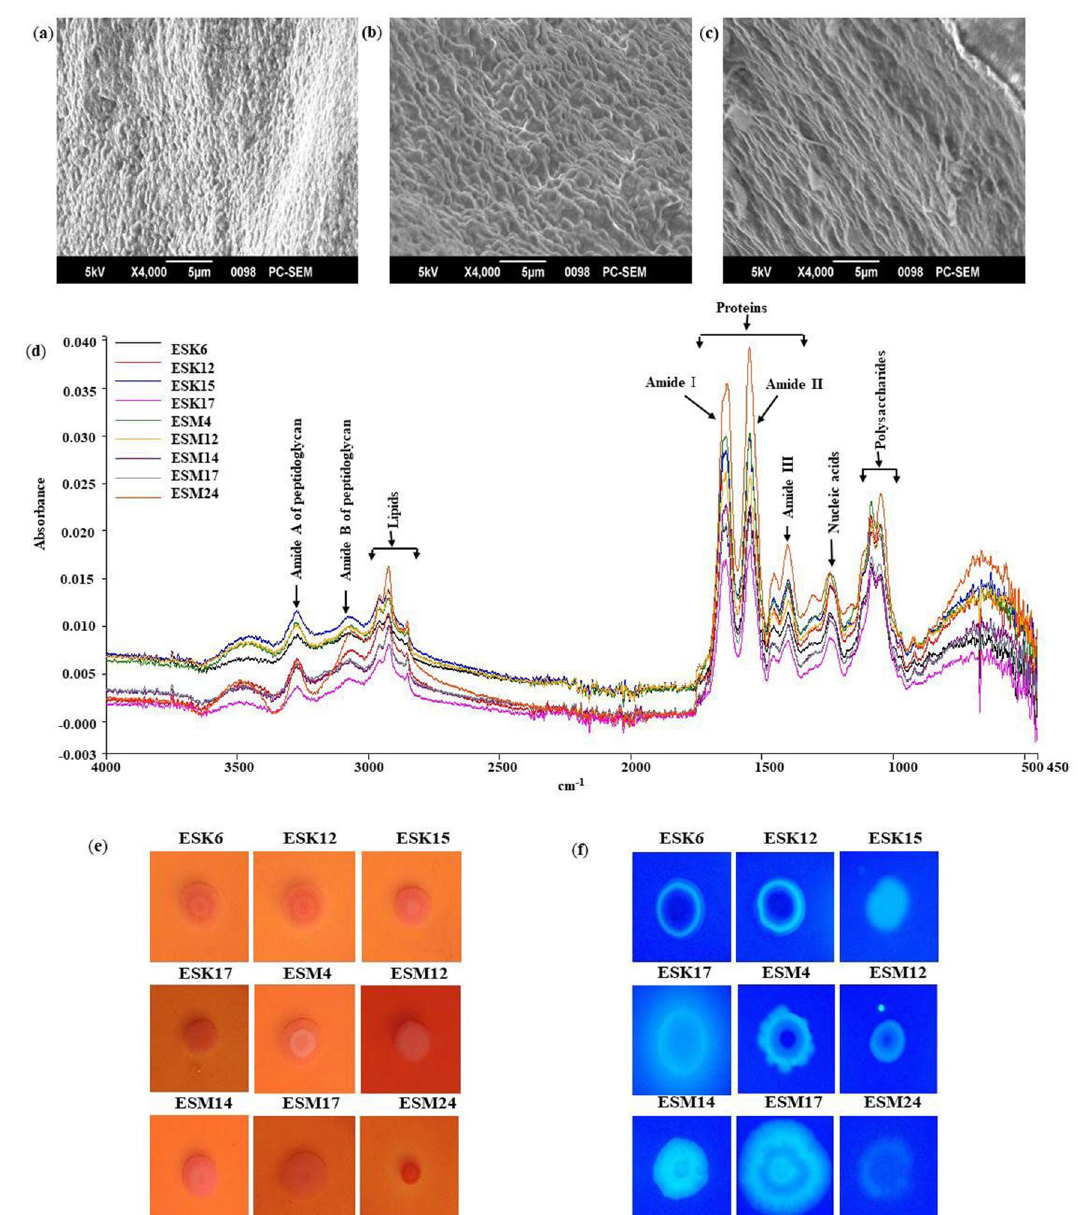
Figure 3. Characterization of the biofilm matrices. Analysis of biofilm matrices from L. adecarboxylata ESK12 ( a ), E. cloacae ESM5 ( b ) and E. acetylicum ESM24 ( c ) by scanning electron microscope. Identification of the biofilm matrix components using FTIR ( d ). Congo red ( e ) and Calcofluor ( f ) binding assays. Photographs ( e , f ) taken after 48 h represent one of two experiments, which gave similar